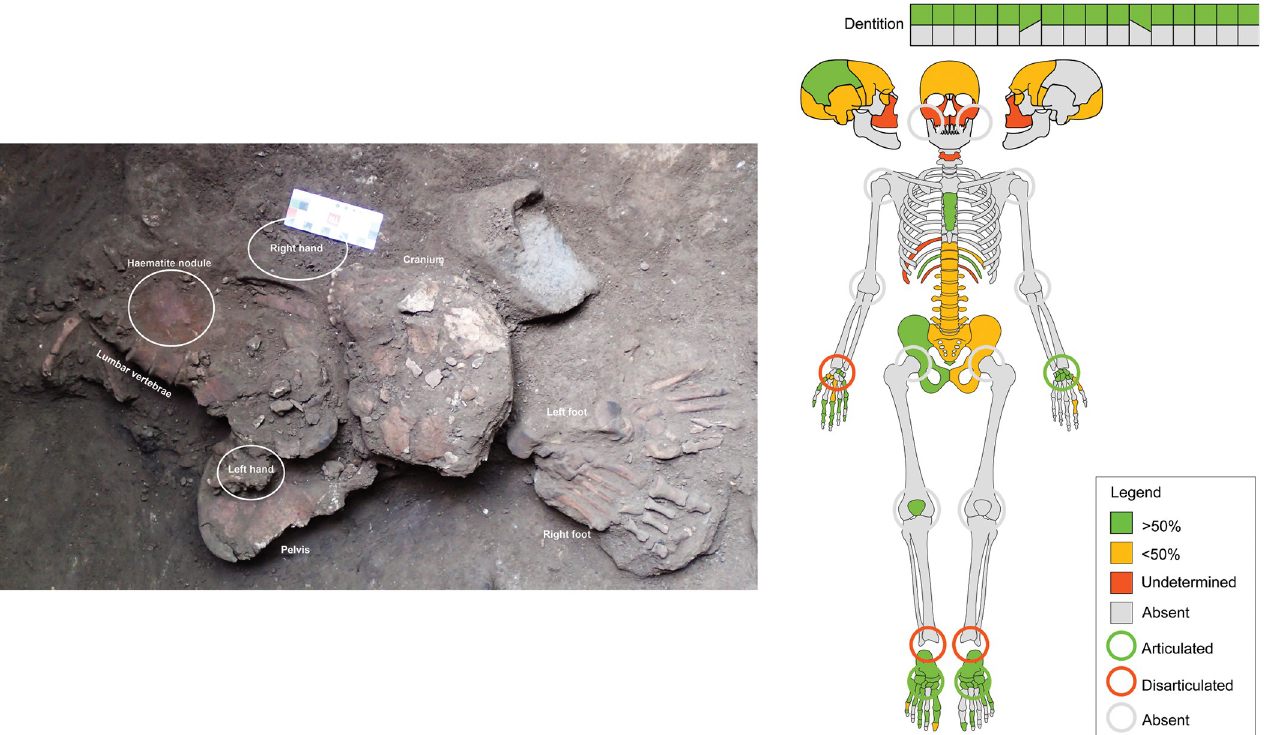
Fig 10. Skeletal elements from E16b. Burial E16b in situ (left). Skeletal diagram indicating the elements documented in the burial and joint assessment